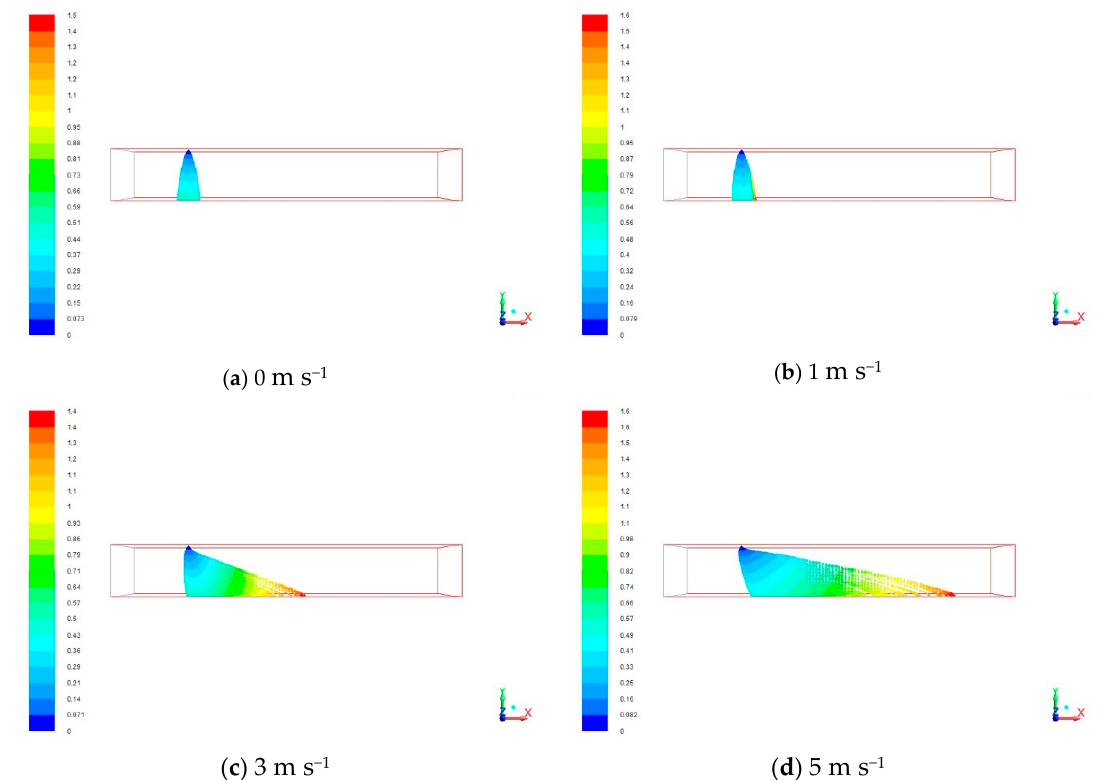
Figure 11. Trace of droplet drift curve at wind speed 0, 1, 3, and 5 m s − 1 when spray height was 1.5 m and inlet pressure was 3 MPa. ( a ) The droplets have no drift at 0 m s − 1 , ( b ) The droplets hardly drift at 1 m s − 1 , ( c ) The droplets have obvious drift at 3 m s − 1 , ( d ) The droplets have serious drift at 5 m s − 1 .